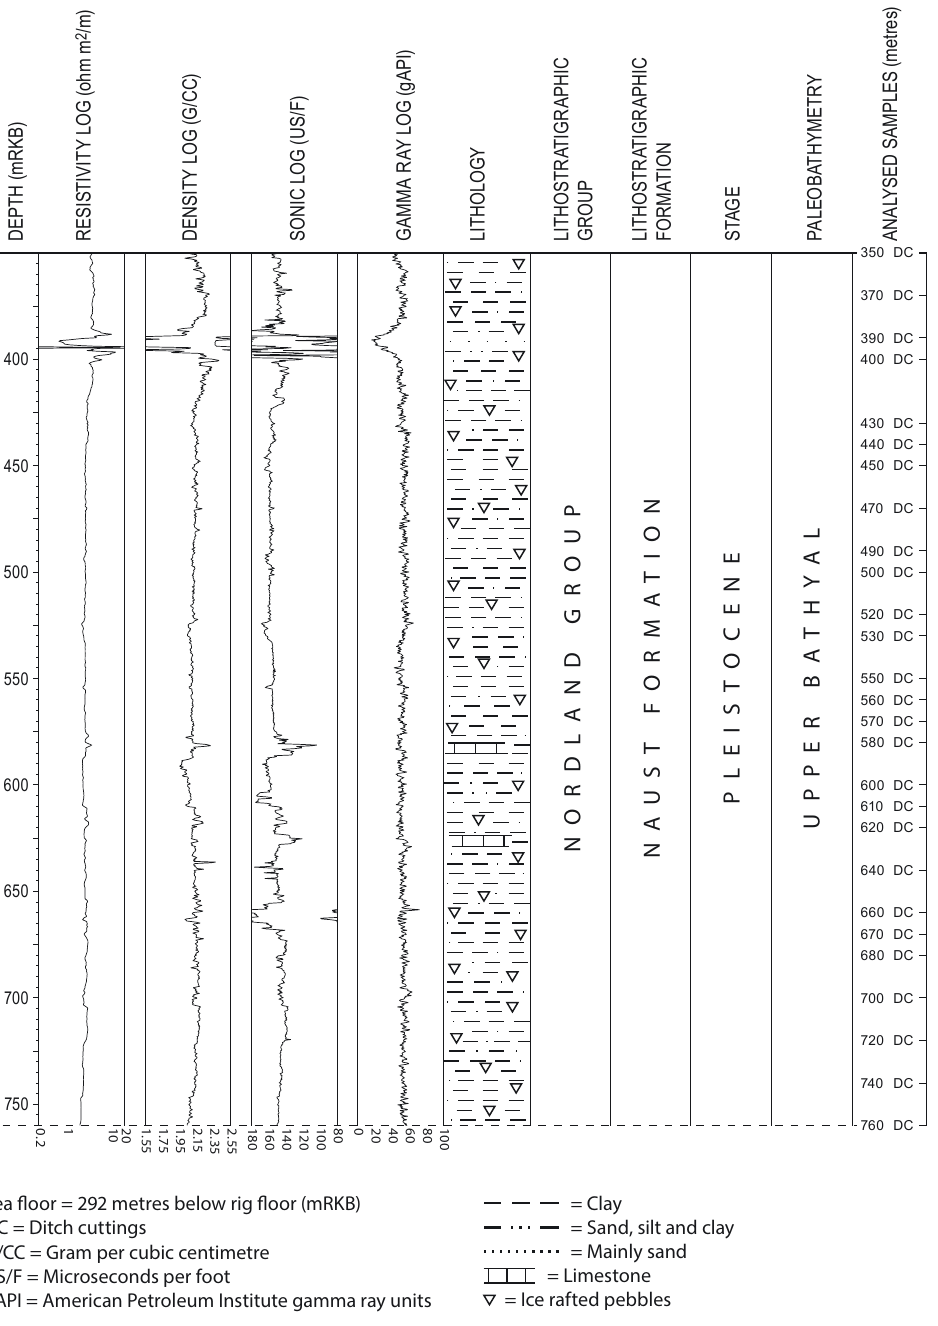
Figure 68. Well summary figure including resistivity log, density log, sonic log, gamma-ray log, lithology, litho- stratigraphic units, stage, paleobathymetry and analysed samples for the upper part of the investigated sequence in well 7117/9–1 (Pleistocene) including the supplementary well reference section for the Naust Formation in the Barents Sea (upper part) (modified after Eidvin & Riis, 1989; Eidvin et al.,